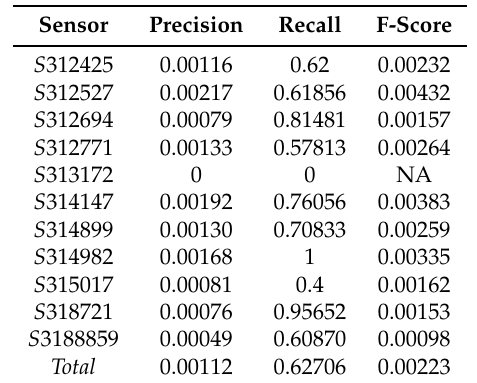
Table 8. Quality of fit for the Phase 1-Test data based on the thresholds determined by the Phase 1-Train incidents using Algorithm 1.